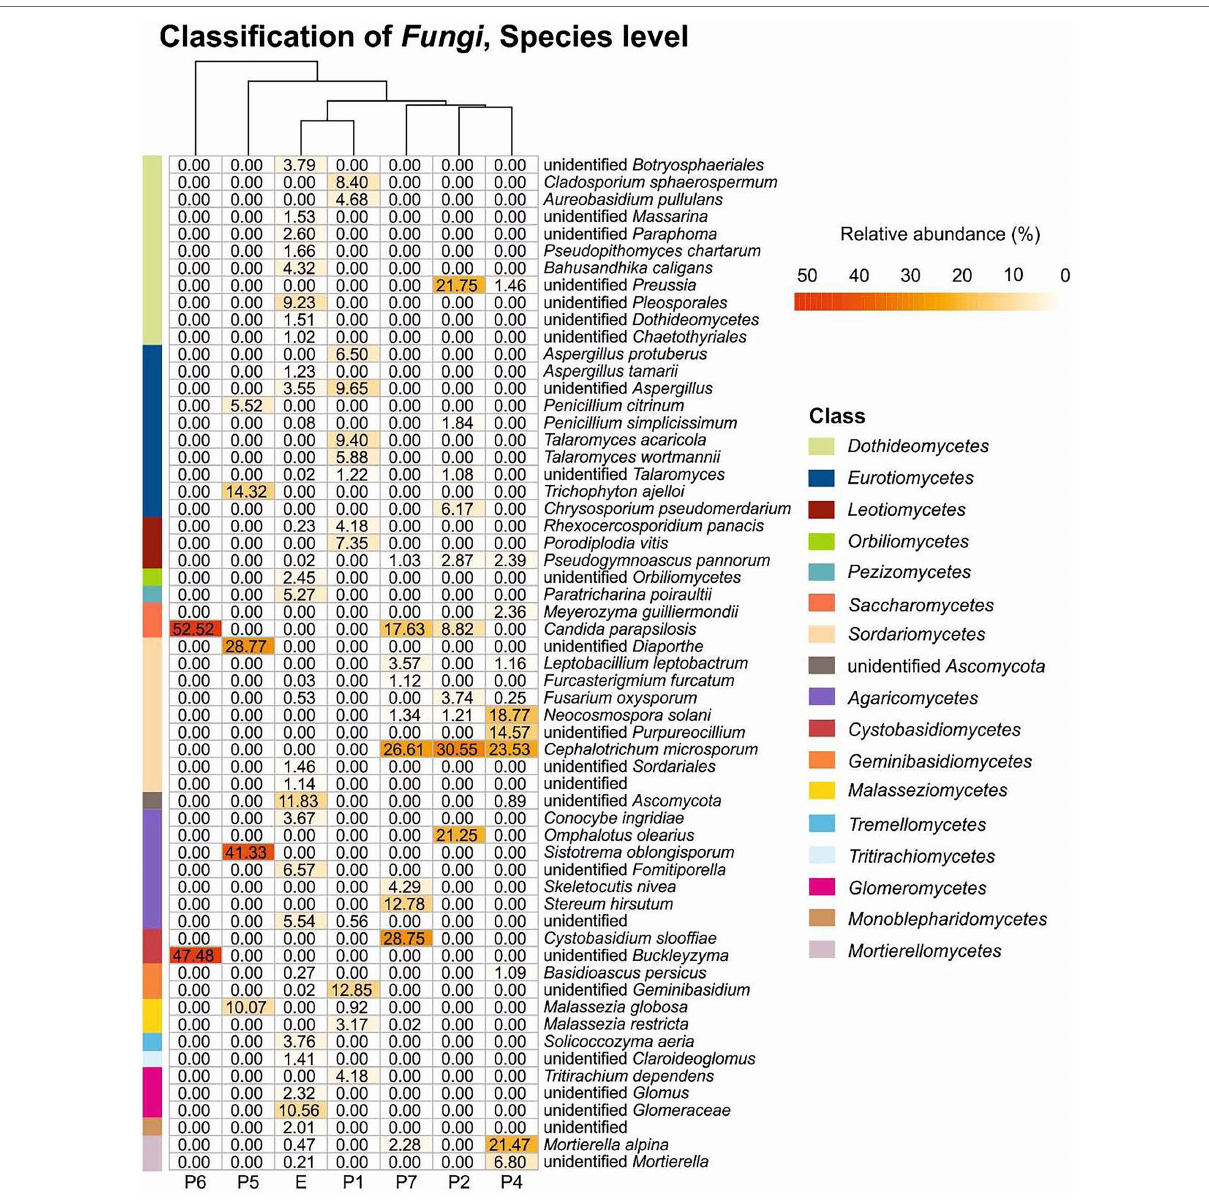
FIGURE 5 | Fungal heat map in Castañar Cave samples. Scales bar show the relative abundance at species level, white squared represents the least abundant species and red the most abundant. Branching patterns on top of each heat map group sediment samples by shared species relative abundance patterns. Bars on the left and the legend on the right indicate the classification at the class level. The species with abundances below 1% are not